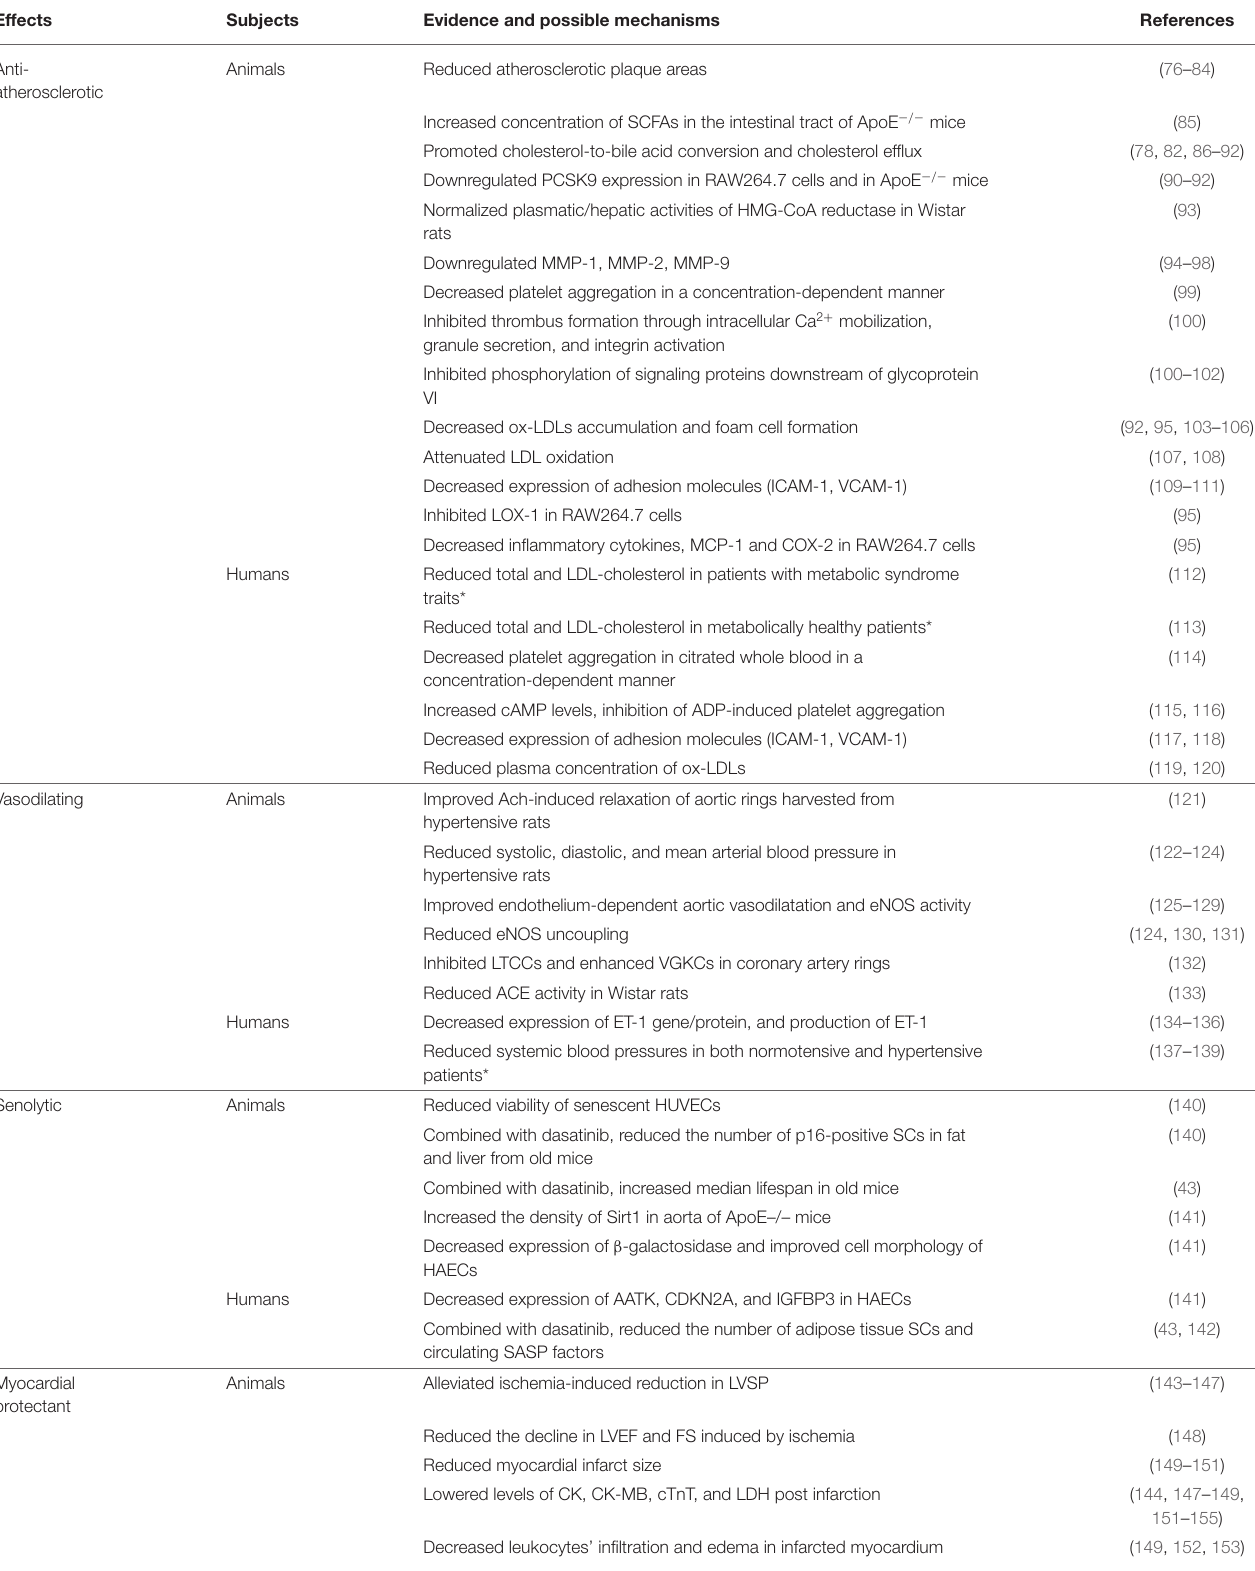
TABLE 1 | Summary of the main in vitro and in vivo cardiovascular effects of